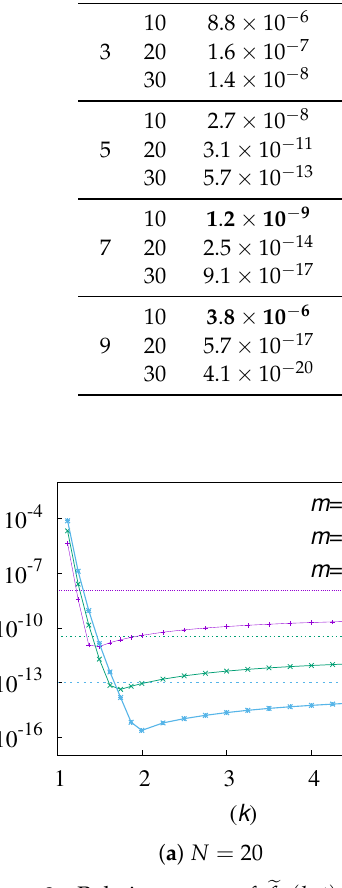
Figure 3. Relative errors of (cid:101) f m ( k ; t ) , 1 < k < 5, for the end-point weakly singular integral I α φ ( ξ 0 ) , with α = − 0.45 and ξ 0 = 1, in Example 2. Dotted horizontal lines indicate relative errors of P Sat m ( t ) for m = 5,7,9 from top to